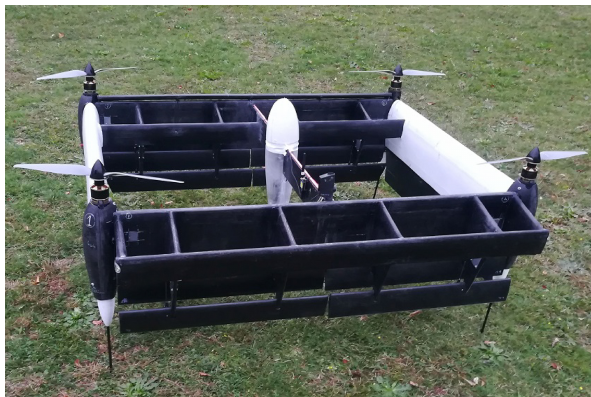
Figure 1. The drone of Skypull AG.